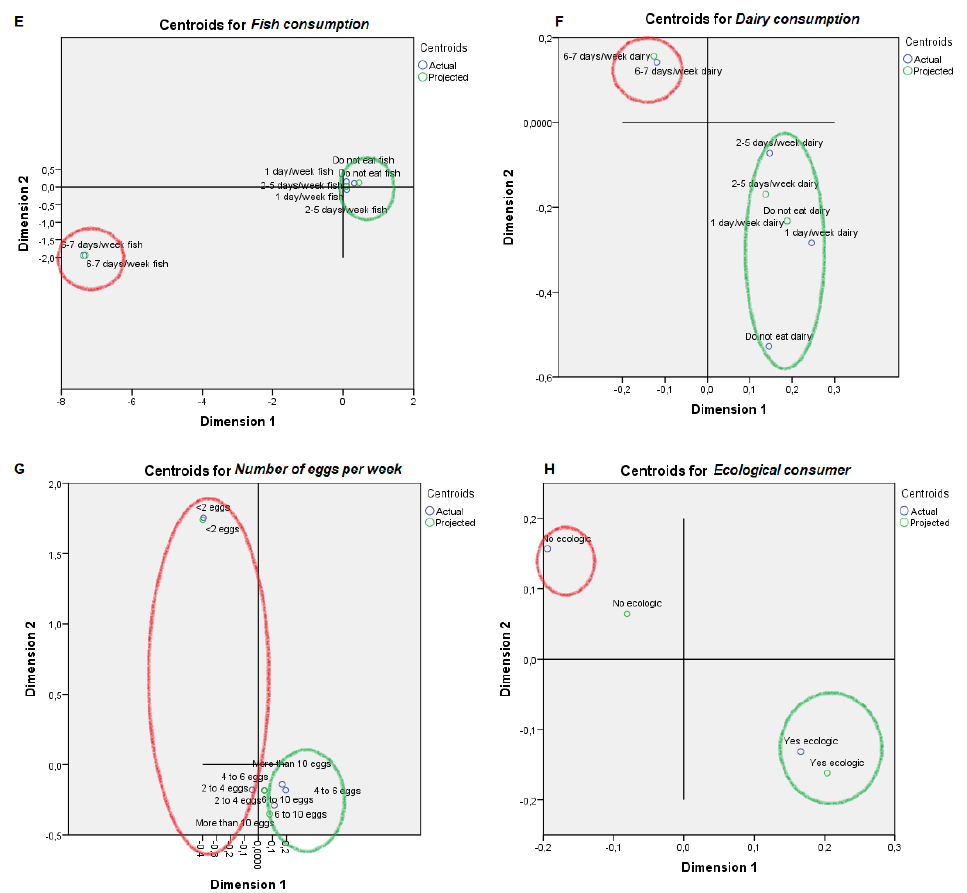
Figure 2. Object scores plot visualization of Professional Customer Profiles with regards panelist diet habits, egg consumption non-affine profile or PPA (red), and affine profile or PPB (green). Panelist diet habits were as follows: ( A ) Egg consumption, ( B ) Vegetable consumption, ( C ) Fruit consumption, ( D ) Meat consumption, ( E ) Fish consumption, ( F ) Dairy consumption, ( G ) Number of eggs per week and ( H ) Ecological consumer.